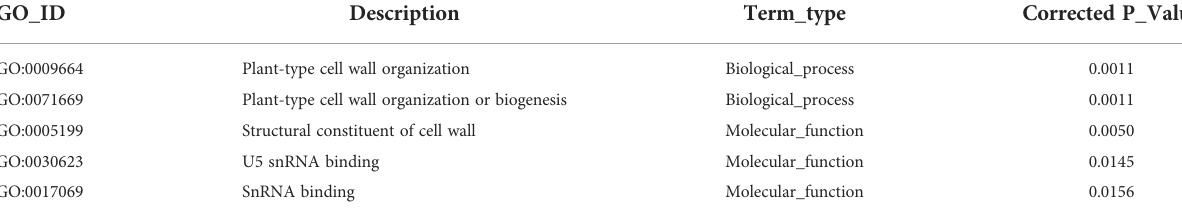
TABLE 1 The GO enrichment analysis of